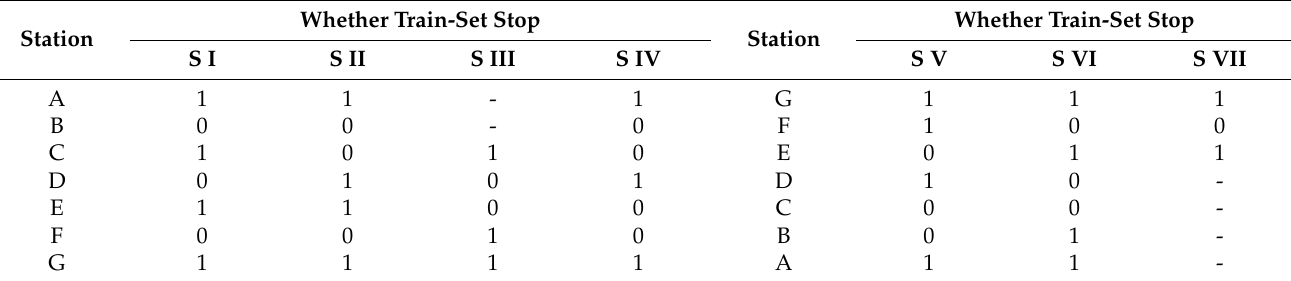
Table 5. An example of stop